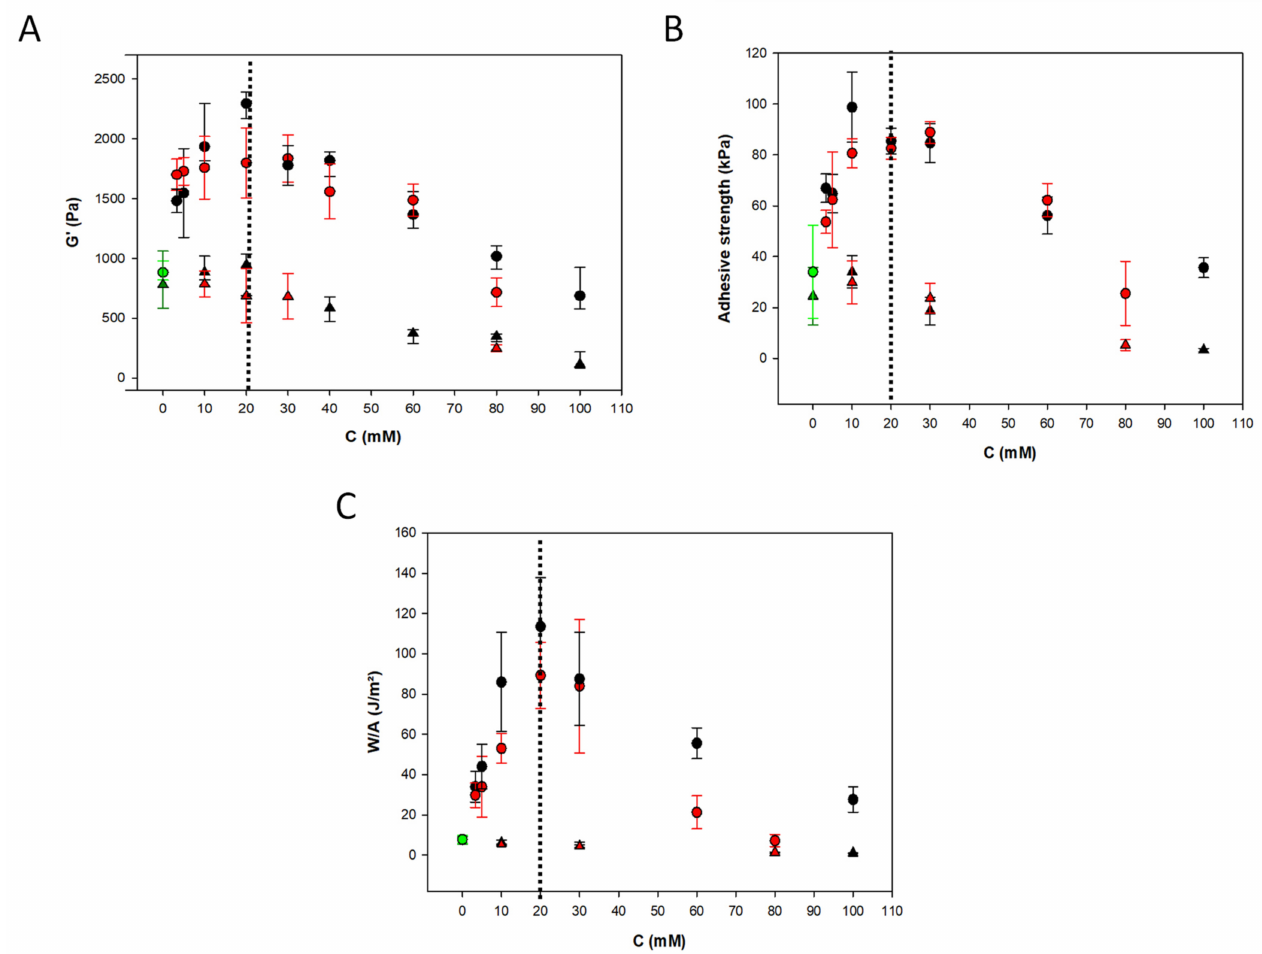
Figure 2. ( A ) Final storage modulus (G (cid:48) ) after 3 h of gelation kinetics for G 10 C y N 10 (black) or G 10 D y N 10 (red) as function of their concentration (circles) and the same experiments without NaIO 4 - triggered oxidation (triangles). The green circles correspond to a pure gelatin gel without NaIO 4 and without catechol or dopamine. ( B ) Adhesion strength ( C ) and debonding energy as function of the catechol (black) or dopamine concentration (red) for gelatin 10% w / v with 10 mM NaIO 4 (circles) or without NaIO 4 (triangles). The green dark triangles correspond to pure gelatin gel at 10% ( w / v ) and the green circles to the 10% ( w / v ) gelatin gel but with 10 mM added NaIO 4 . In all the graphs, the error bars correspond to ± one standard deviation over three independently prepared gels. The dotted lines in all panels are aimed to qualitatively identify the optimal catechol or dopamine concentration in terms of gel elasticity and